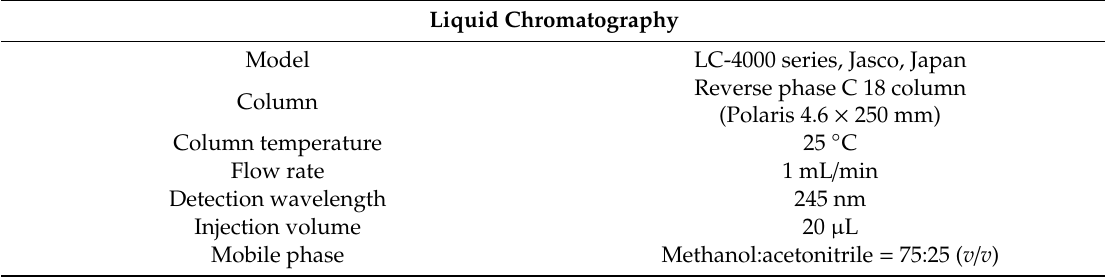
Table 1. Characteristics of the high-performance liquid chromatography (HPLC) system